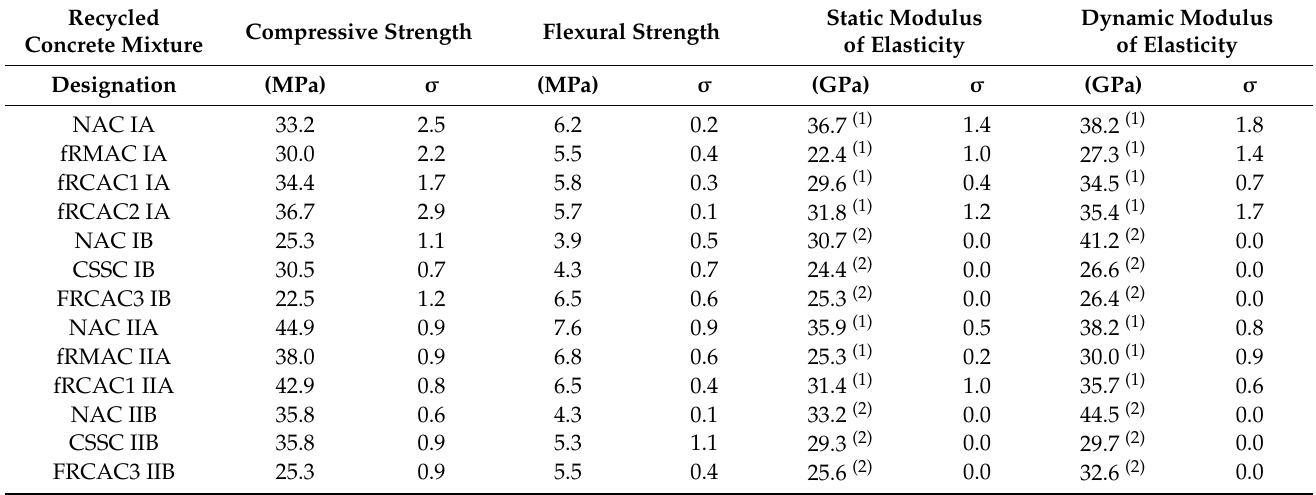
Table 6. Average values and standard deviation of results of mechanical properties of concrete at age of 28 days.